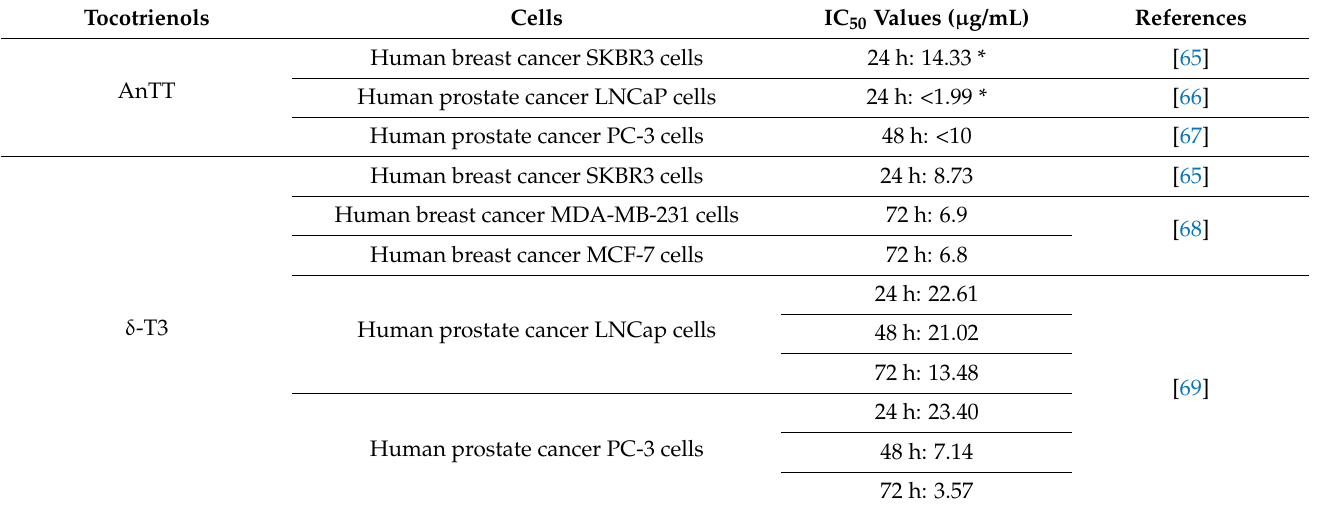
Table 2. IC 50 values of AnTT, γ -T3 and δ -T3 from previous studies.